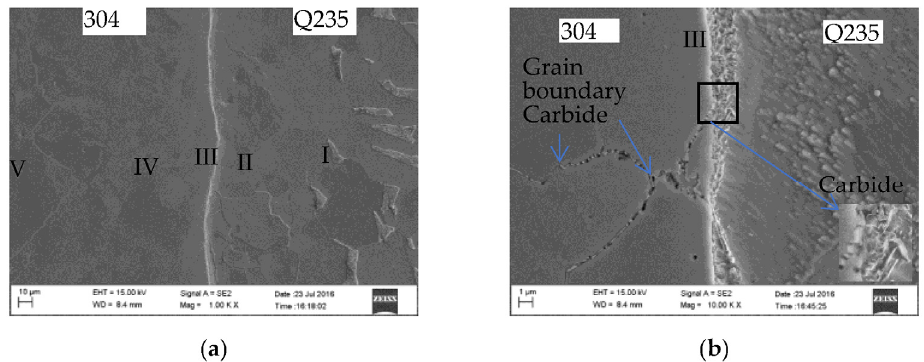
Figure 3. Scanning electron microscopy of microstructure near the interface: ( a ) The five zones (I – V) of the bonding joint. ( b ) The carbides in the (III) transition zone and the austenite grain boundary.